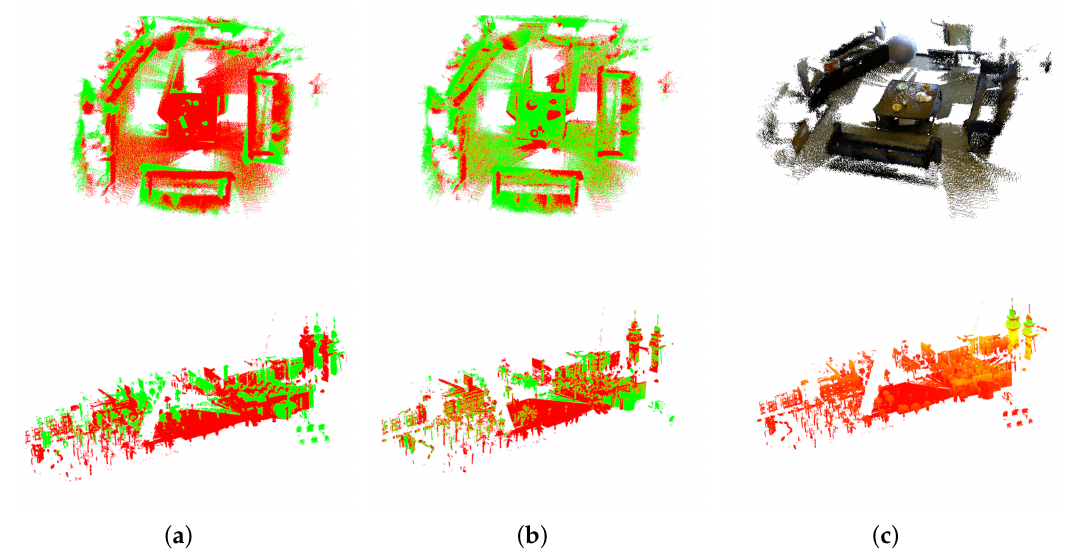
Figure 13. Multi-view registration through our approach to scene data. ( a ) Input point clouds; ( b ) the registration results; ( c ) RGB rendering